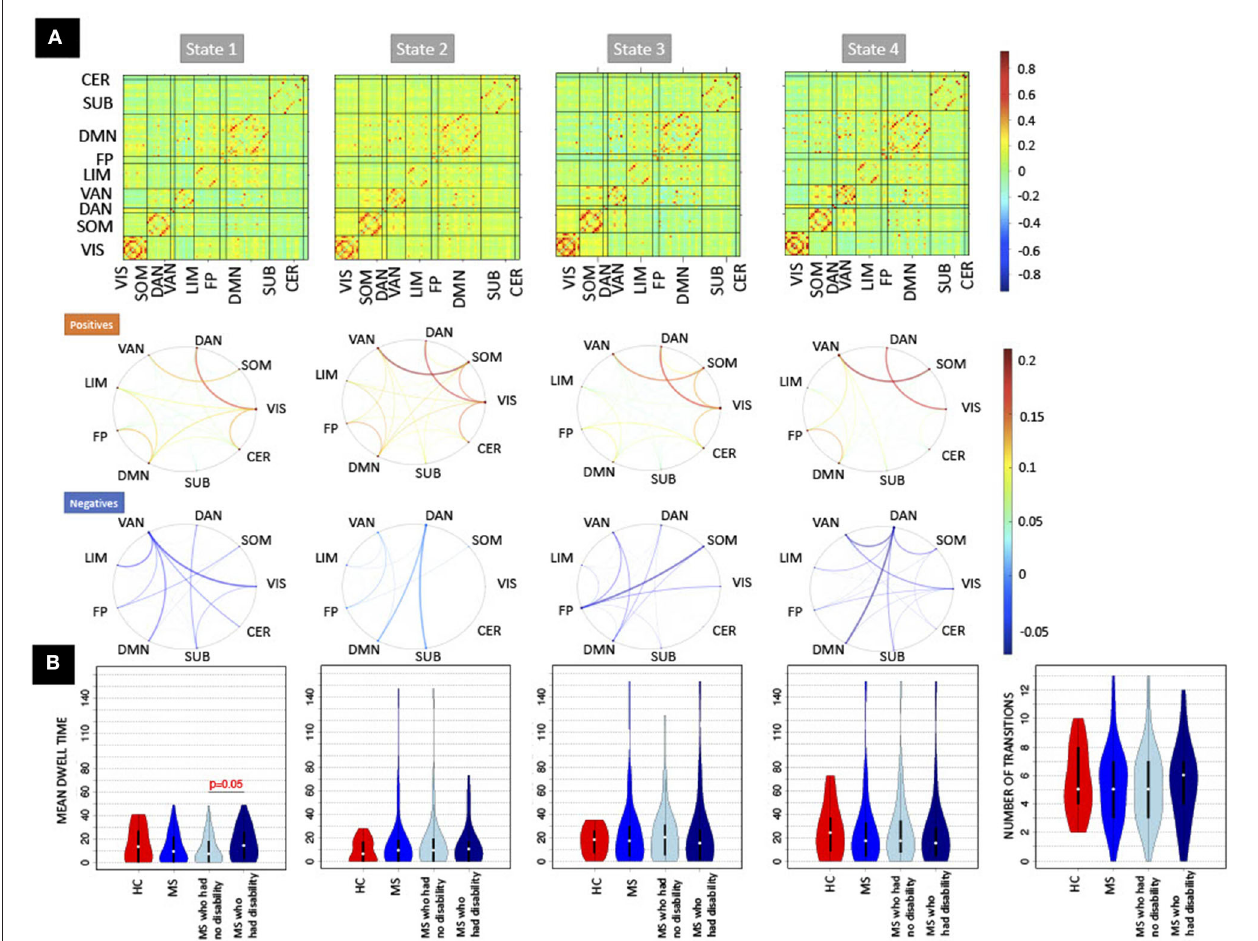
FIGURE 2 | The recurring dynamic FC brain states obtained with k-means clustering and the dFC metrics (dwell time and number of transitions). (A) (Top row) Heat maps show the dynamic functional connectivity centroids for the four states, while [bottom two rows of (A) ] the circle plots summarize the dFC centroids at a network level with the positive and negative dFC entries averaged separately. The color bar of the circle plot is not symmetrical, as to better visualize the network-level values. (B) The dFC metrics (mean dwell time and number of transitions) obtained for HC, pwMS, pwMS who had no disability, and pwMS who had evidence of disability. DAN, Dorsal Attention; VAN, Ventral Attention; LIM, Limbic; FP, Fronto-Parietal; DMN, Default-Mode Network; SUB, Subcortex; CER, Cerebellum; VIS, Visual; SOM,